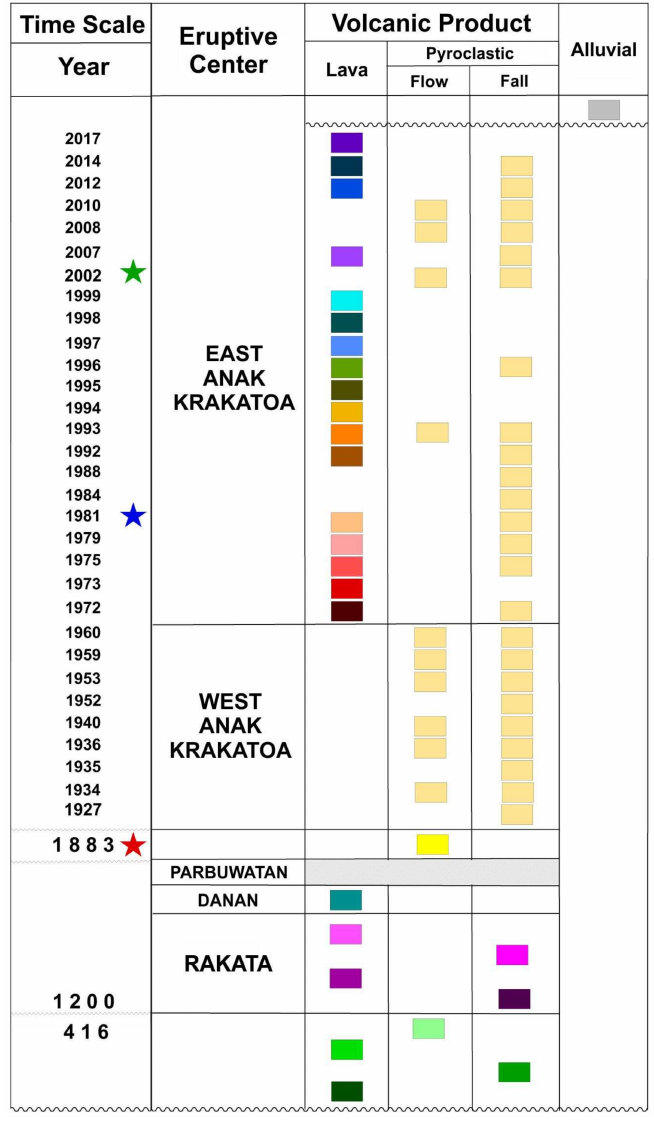
Figure 3. Stratigraphy of the Krakatoa complex. Sample positions indicated by red star for 1883, blue star for 1981 and green star for 2002. Samples are taken from